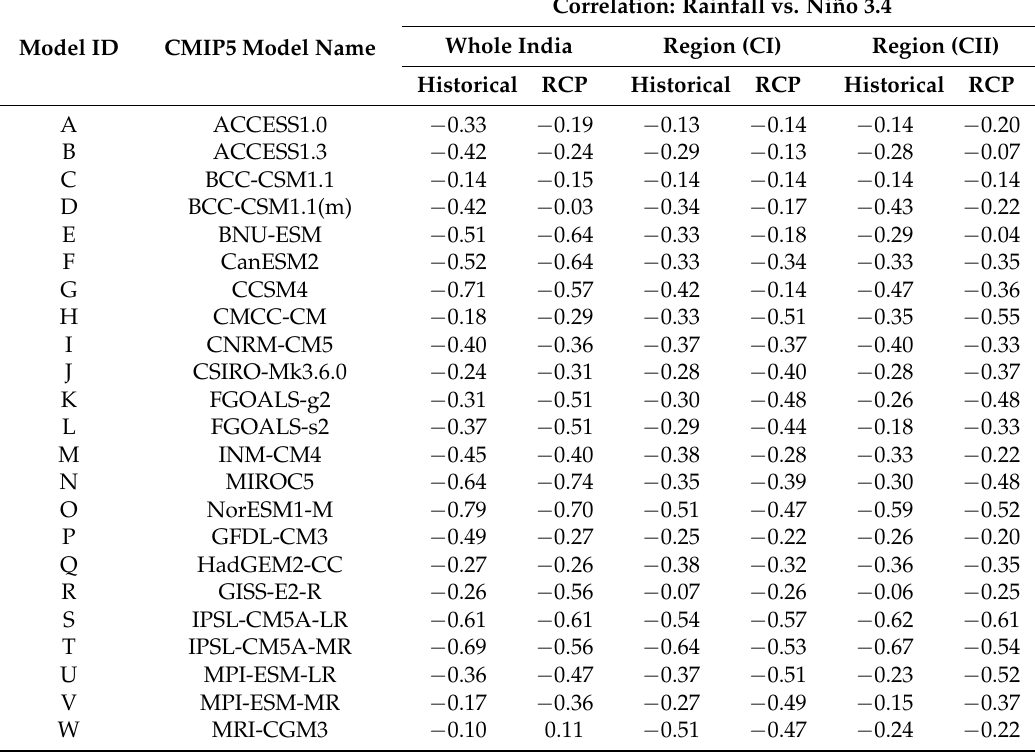
Table 2. ISM and ENSO correlation using various CMIP5 models (in the whole Indian subcontinent and the two regions, CI and CII) during the historical and RCP 8.5 scenario, after removing the